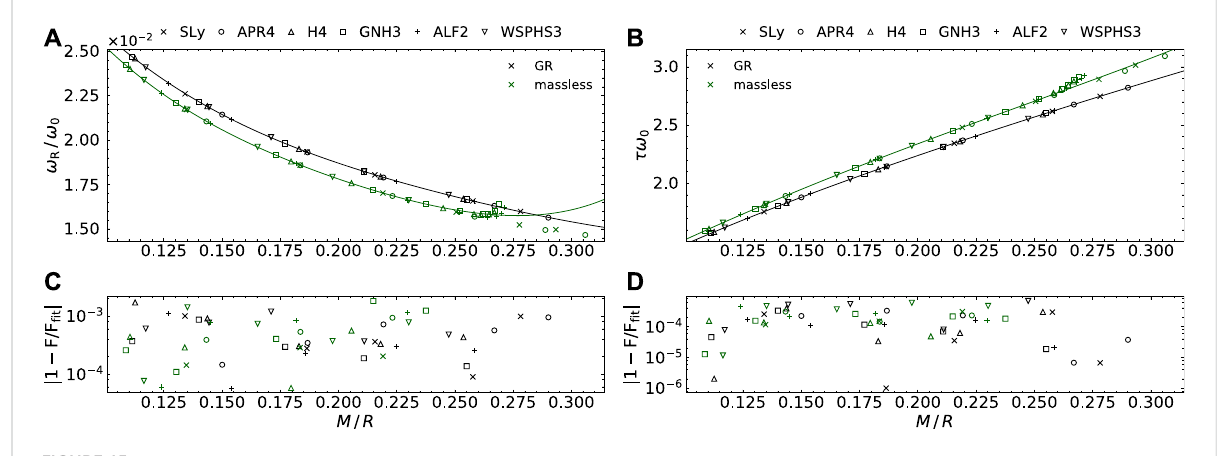
FIGURE 15 Radial ϕ -mode universal relations: dimensionless frequency ω R / ω o versus compactness C = M / R (A) and fi t errors (C) ; dimensionless damping time τω o versus compactness C (B) and fi terrors (D) .Thesymbolsindicatetherespectiveequationofstate.Themasslessscalar – tensorcaseisshown in green, and the general relativistic case is shown in black.